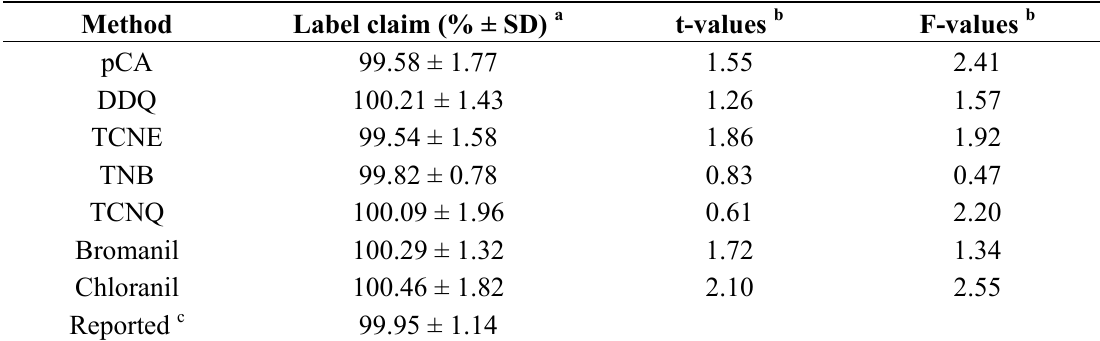
Table 4. Determination of ROS-Ca in its tablets by the proposed